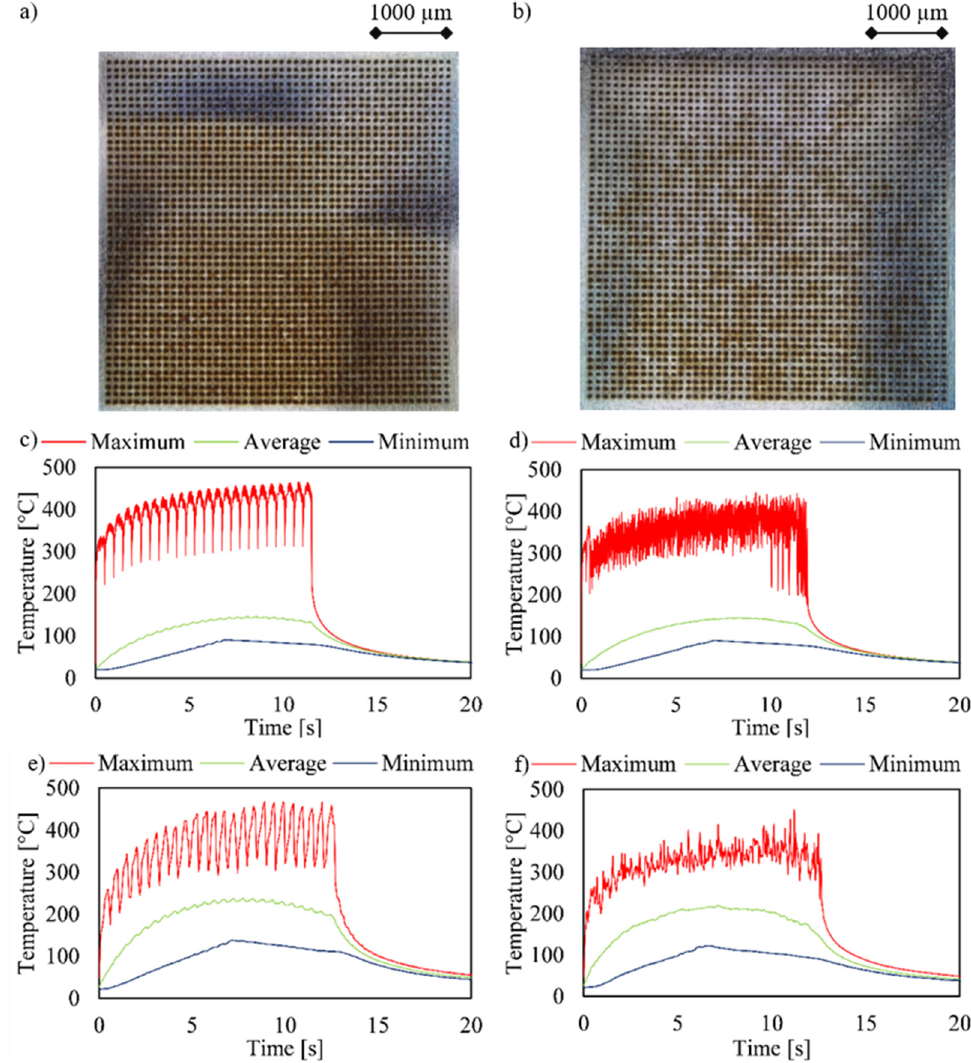
Figure 7. The microscope images ( a , b ), simulated temperature plots from COMSOL ( c , d ), and temperature plots ( e , f ) taken with a thermal imaging camera of a 48 × 48 array with a 100 µm separation distance. The holes were drilled using a 2 × 2 beam splitter and a power of 2.3 W and a repetition rate of 50 kHz. The drilling process was performed using the delays to correct the process time. ( a , c , e ) correspond to the standard drilling sequence, ( b , d , f ) to the optimized drilling sequence.